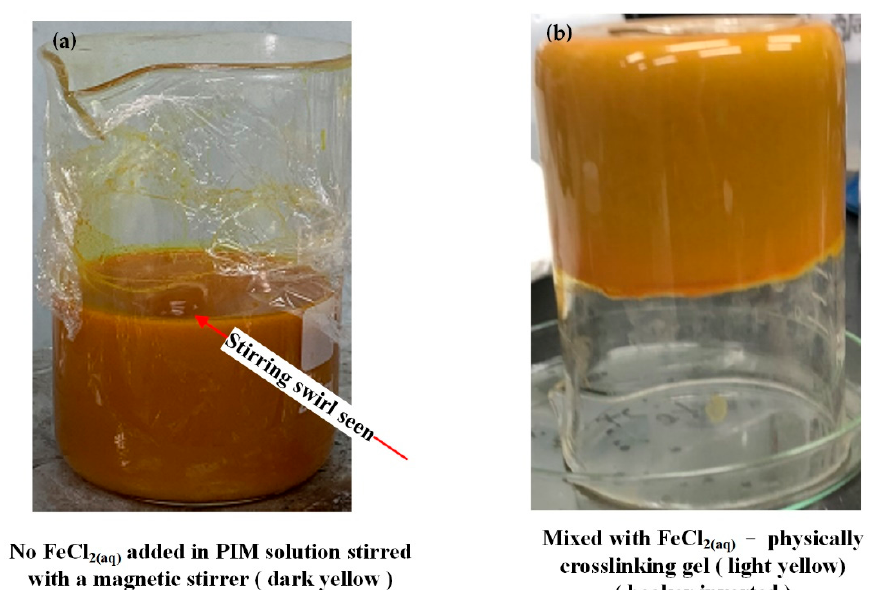
Figure 2. Pictures of PIM alcohol solution ( a ) without FeCl 2(aq) and ( b ) with FeCl 2(aq)